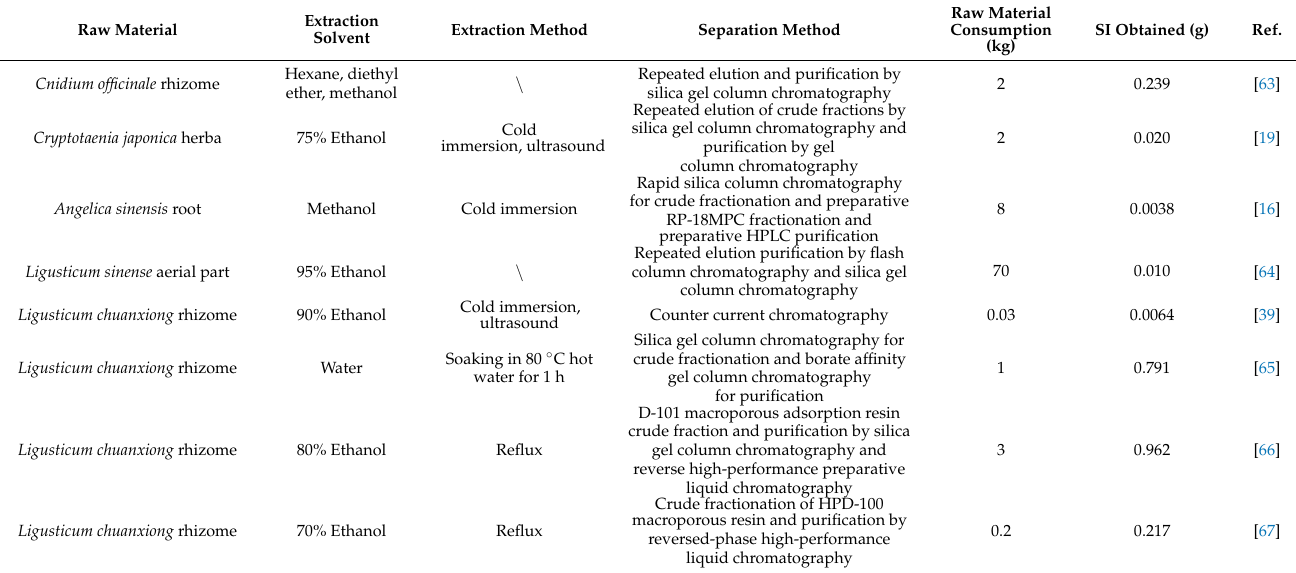
Table 4. Extraction and isolation of SI.